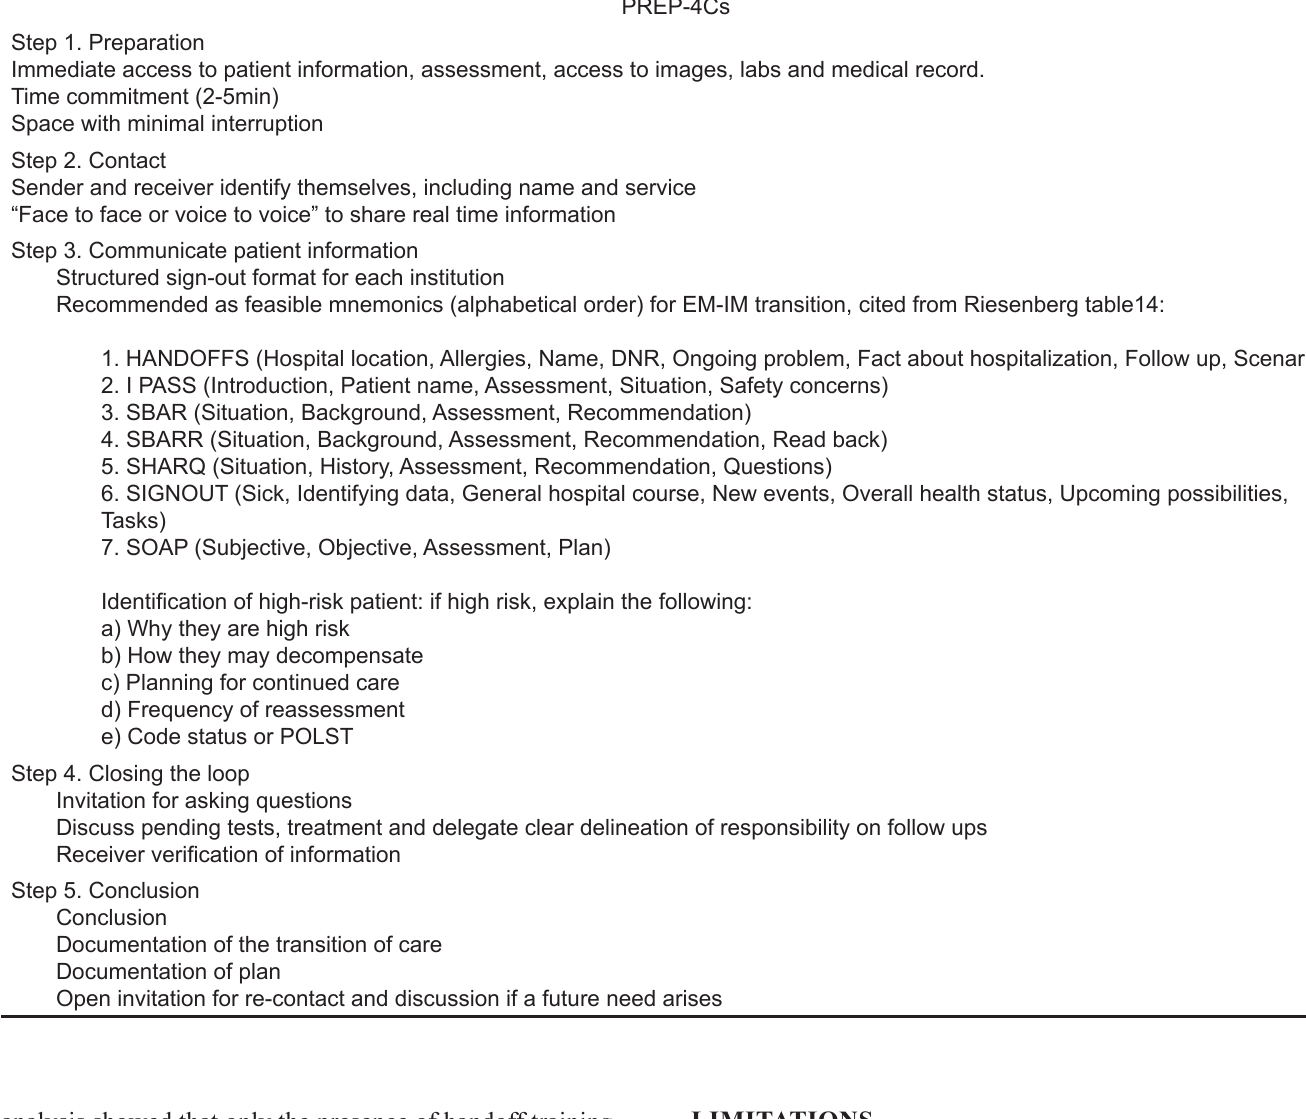
Table 3. EM-IM transition of care algorithm